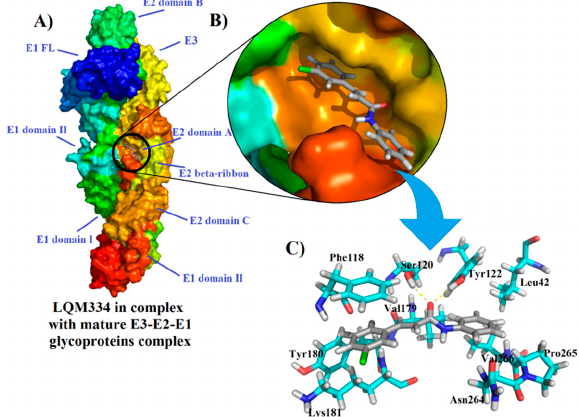
Figure 9. Interactions of LQM334 with mature E3-E2-E1 glycoproteins complex (PDB ID: 3N41) from the Chikungunya virus and its amino acids involved ligand-target complex. In ( A ), Overview of LQM334-mature E3-E2-E1 glycoproteins complex formation; In ( B ), Magnification showing the LQM334 into the central cleft from the glycoproteins complex; In ( C ), stick representations showing the amino acids involved in the complex formation with LQM334, in which yellow dots represent hydrogen bonding